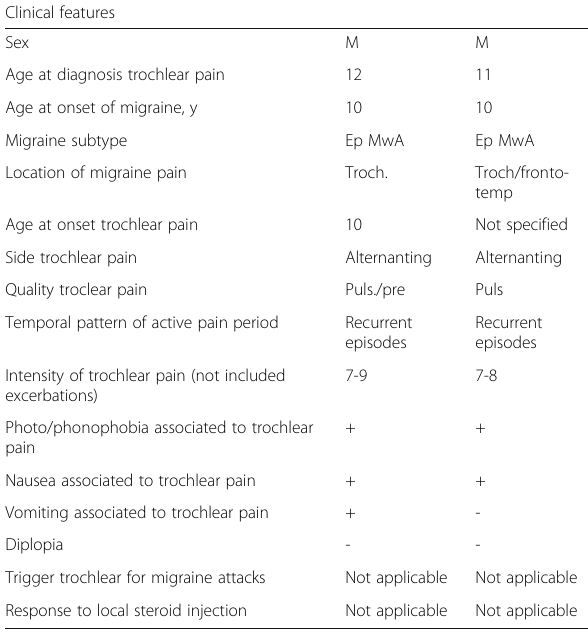
Table 1 (abstract P129). Trochlear migraine – two case report Clinical